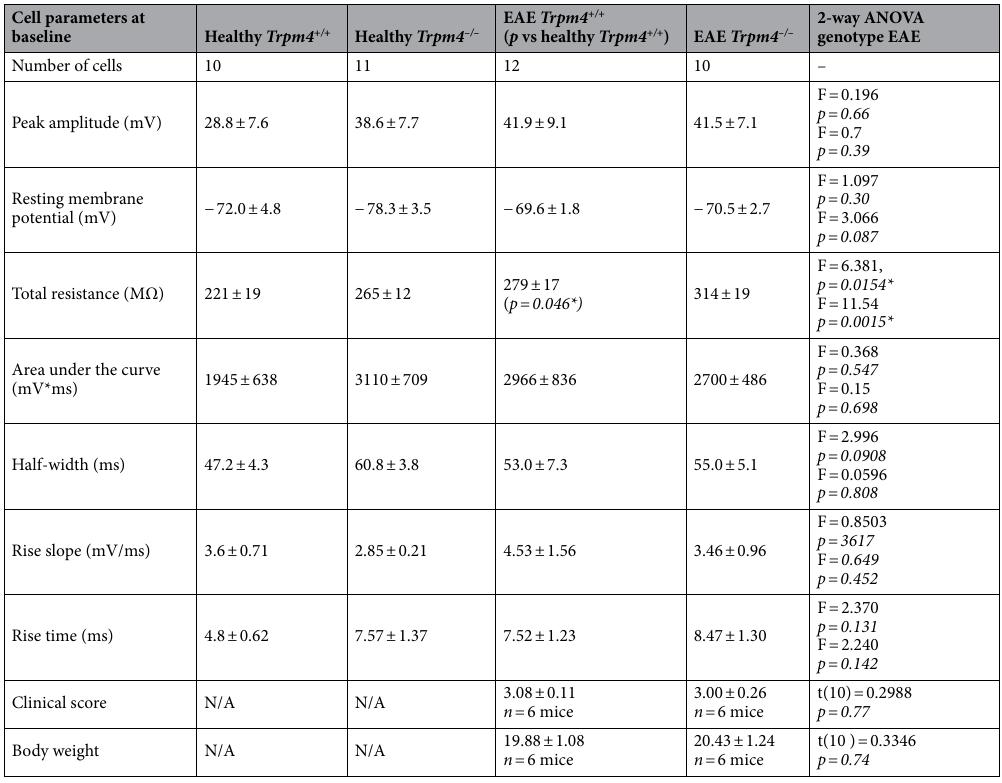
Table 1. Only cell resistance significantly varies between genotype or health status at baseline. All measurements are taken from the baseline prior to drug wash-in. Data are mean ± SEM. The degrees of freedom are (1, 42) for all parameters except clinical score and body weight. Upper pair of F and p values are for genotype ( Trpm4 + / + vs Trpm4 –/– ) comparisons and the lower pair are for treatment (EAE vs. healthy) comparisons. For clinical score and body weight, unpaired t-tests were used. n -size is indicated within each